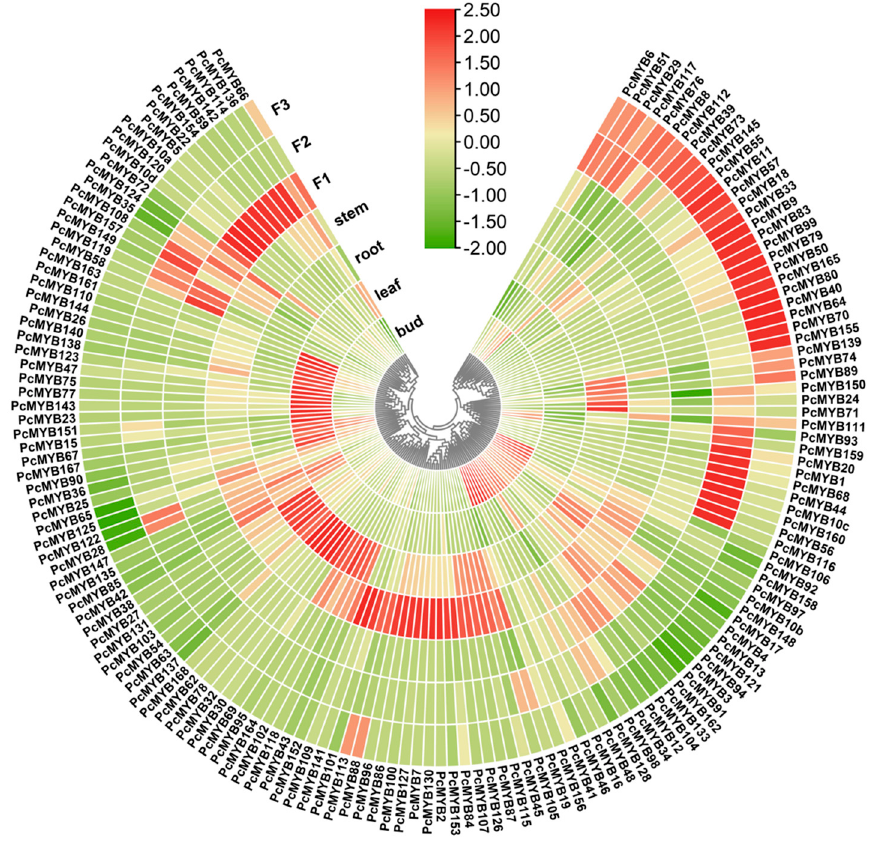
Figure 8. Expression profiles of the MYB genes in various tissues. F1: flowers at the initial flowering stage; F2: flowers at the full flowering stage; F3: flowers at the late flowering stage. The color bar in the middle indicates log2 expression values, with red representing high levels and green representing low levels of expression.